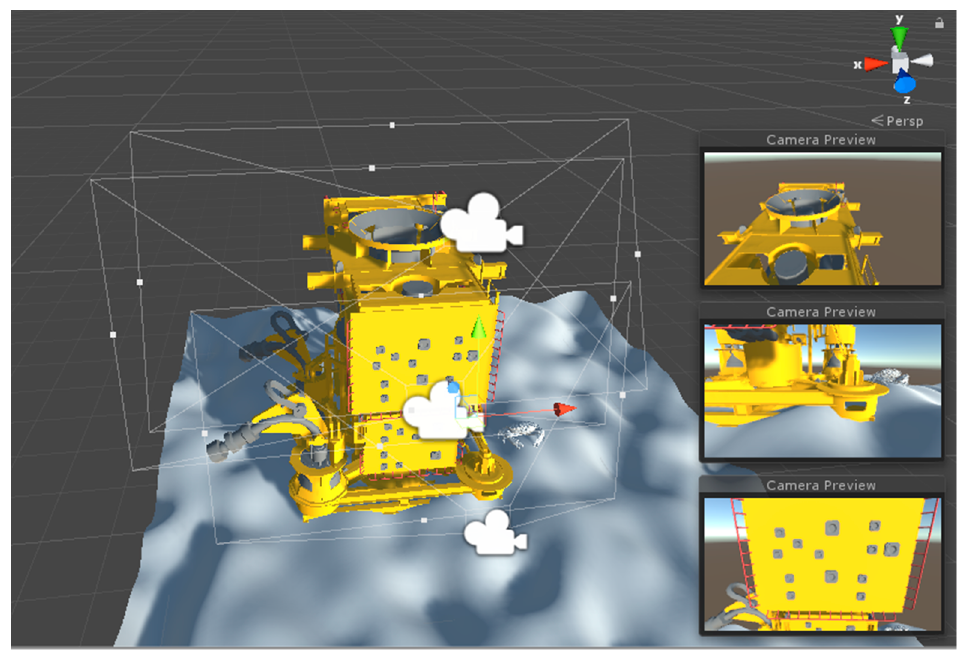
Figure 4. Definition of the sensor path for scanning an oil well Christmas tree. The cinecameras are Unity camera objects used to represent the sensor scan position. The camera preview screens show what the device is seeing inside its field of view [29].